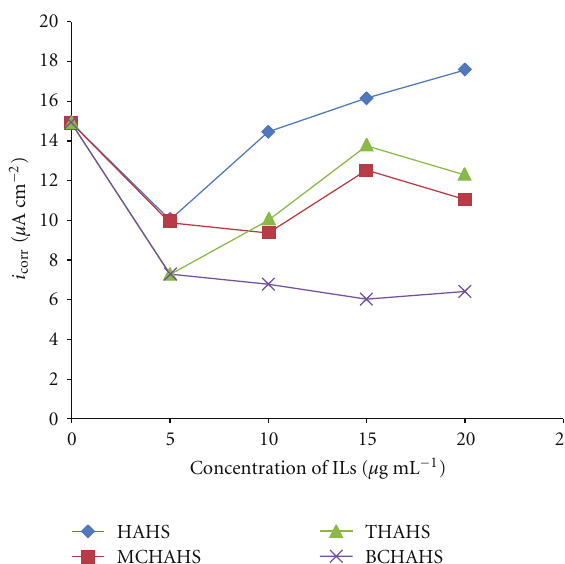
Figure 4: Corrosion current of Pb-Sb-Sn electrode in various ILs concentration is in 4.0 mol · L − 1 H 2 SO 4 . Conditions: scan rate, 5mVs − 1 ; immersion time, 5min.